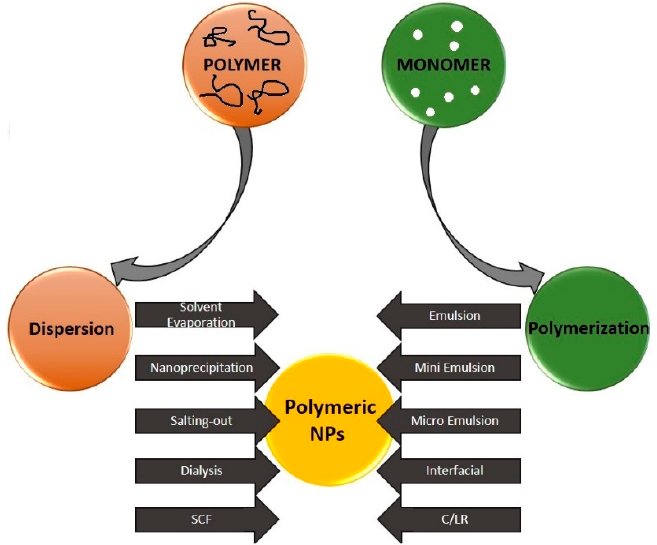
Figure 3. Schematic representation of various techniques for the preparation of polymer nanoparticles. SCF: supercritical fluid technology, C/LR: con-trolled/living radical. Reproduced from Rao and Geckeler [32] with permission of